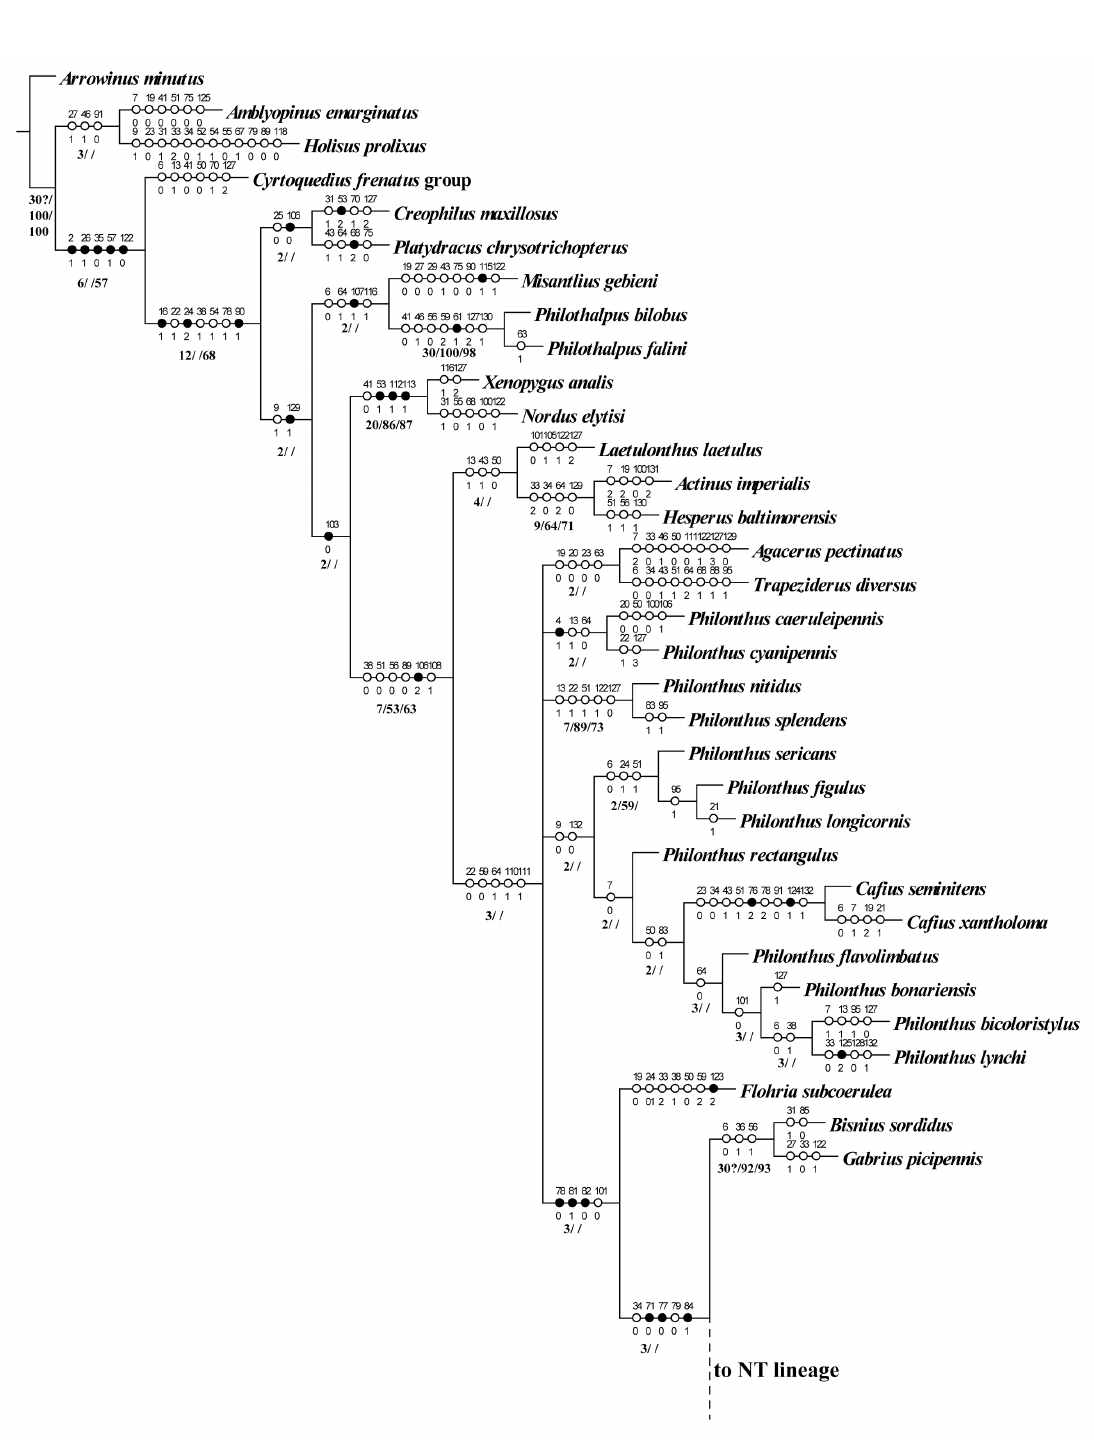
Fig. 6 (continued on next page). Strict consensus of the 28 MP trees obtained showing the systematic placement of Ophionthus Bernhauer, 1908 within the Neotropical lineage of Philonthina Kirby, 1837 (tree length = 579; consistency index (CI) = 0.24; retention index (RI) = 0.71. Black circles: exclusive synapomorphies; open circles, non-exclusive synapomorphies. Numbers above circles are character numbers; numbers below circles represent character states. Support values are indicated in bold below the branches as follows: Bremer/Standard Bootstrap/Jack-knife (cut = 50 for resampling support